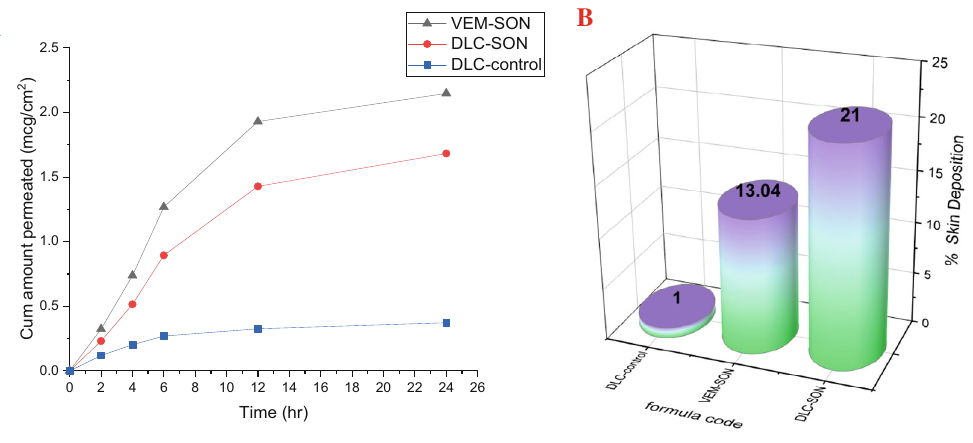
Figure 9. Ex vivo studies of VEM from DLC-SON and DLC-control in comparison to the optimum VEM-SON (A) ex vivo permeation study (B) Skin deposition study.